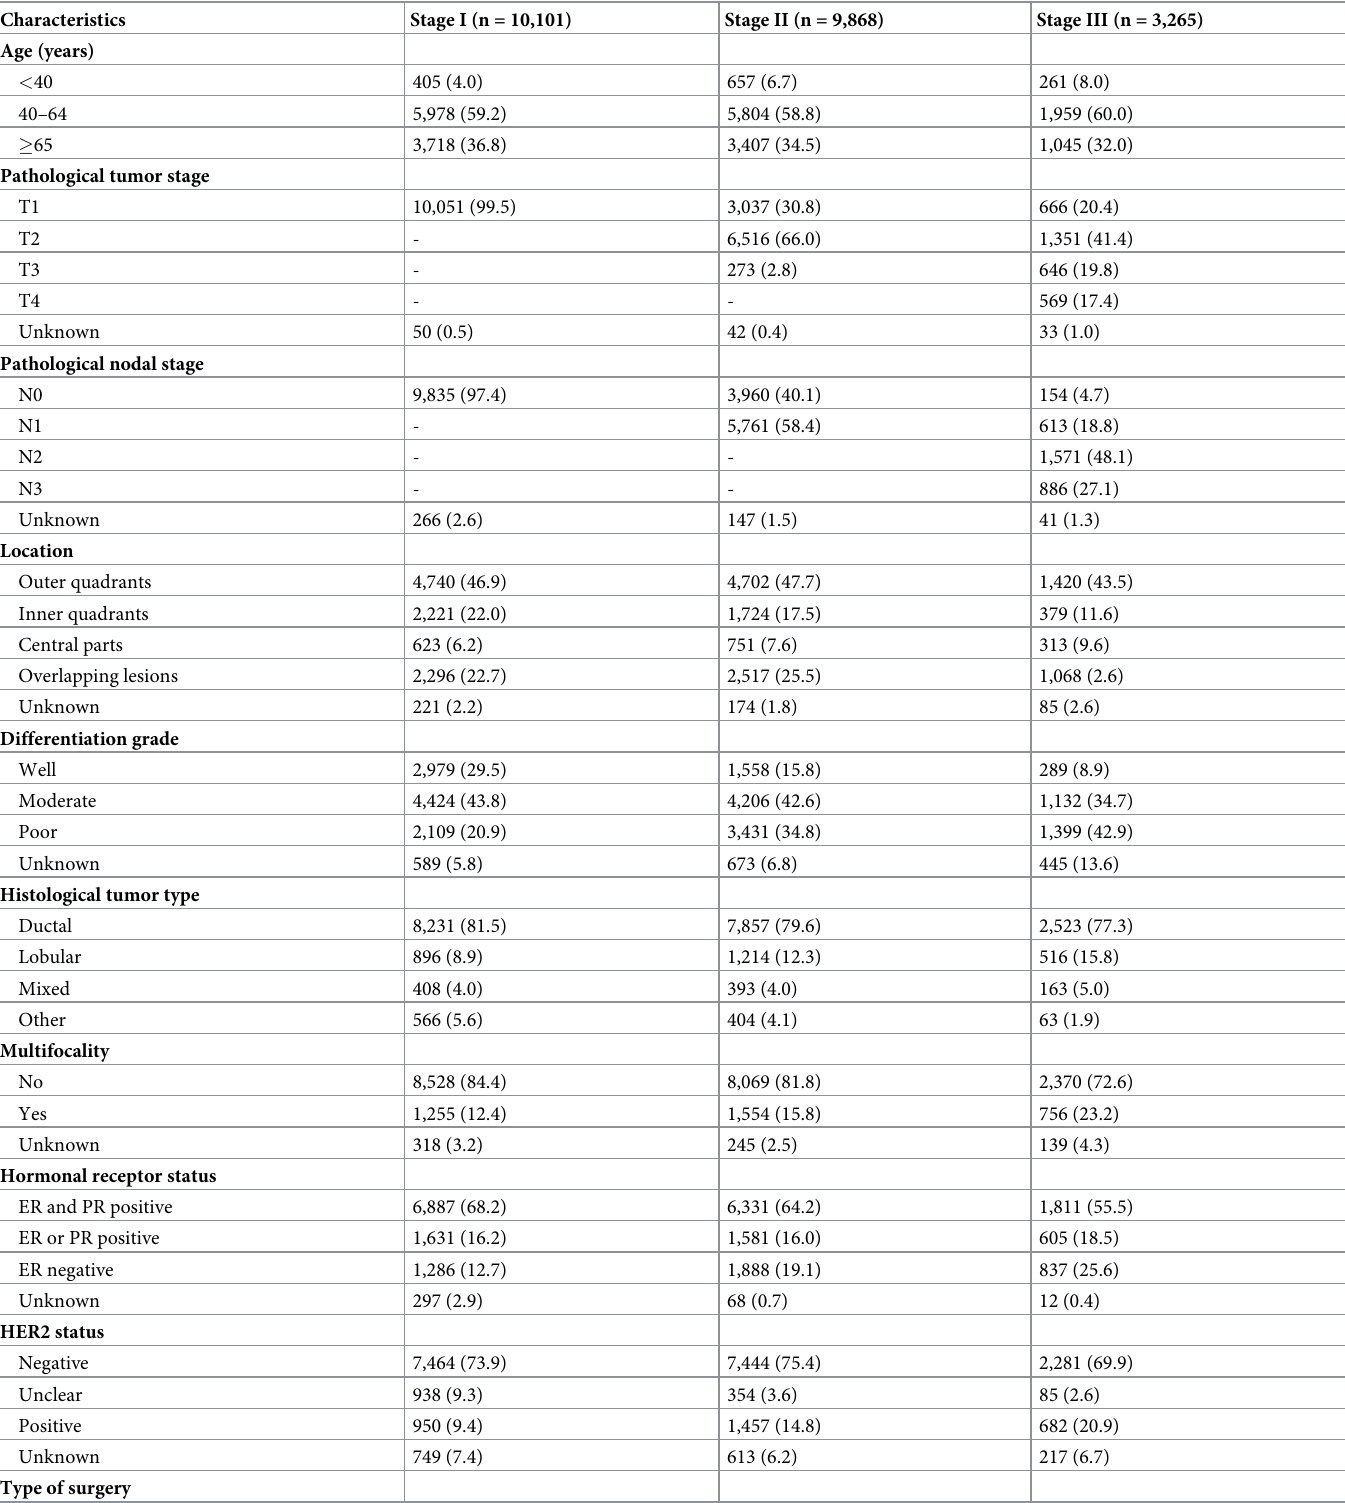
Table 1. Patient-, tumor-, and treatment-related characteristics.